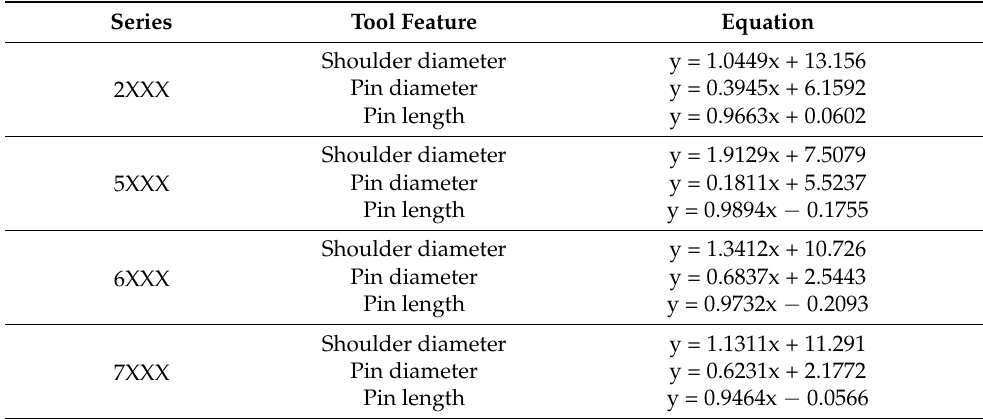
Table 3. Summary of equations by aluminum series and tool parameter.